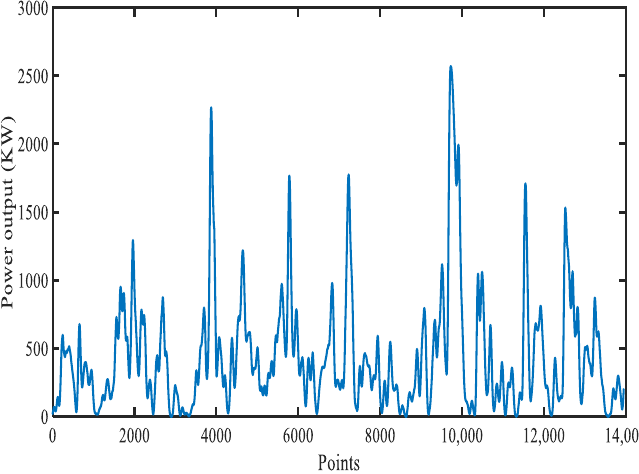
Figure 7. Actual power generation of the wind turbine.